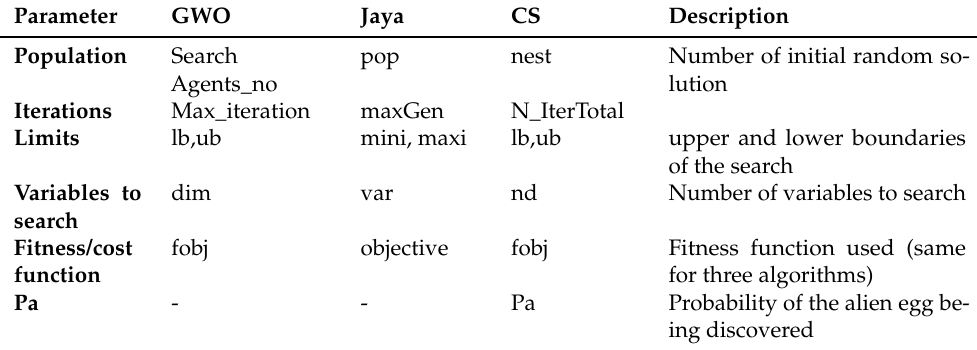
Table 3. Name parameters and equivalence in each